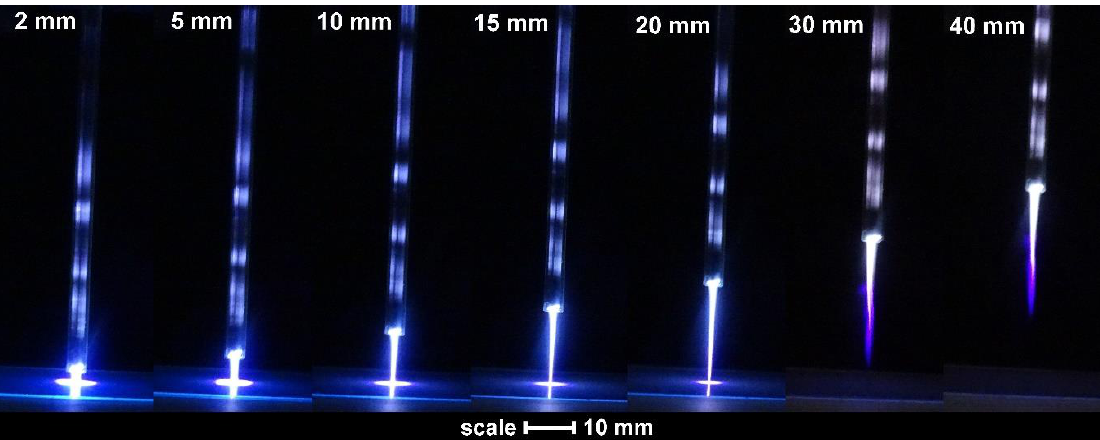
Figure 2. Photos of the plasma jet at various distances of the nozzle from the sample.